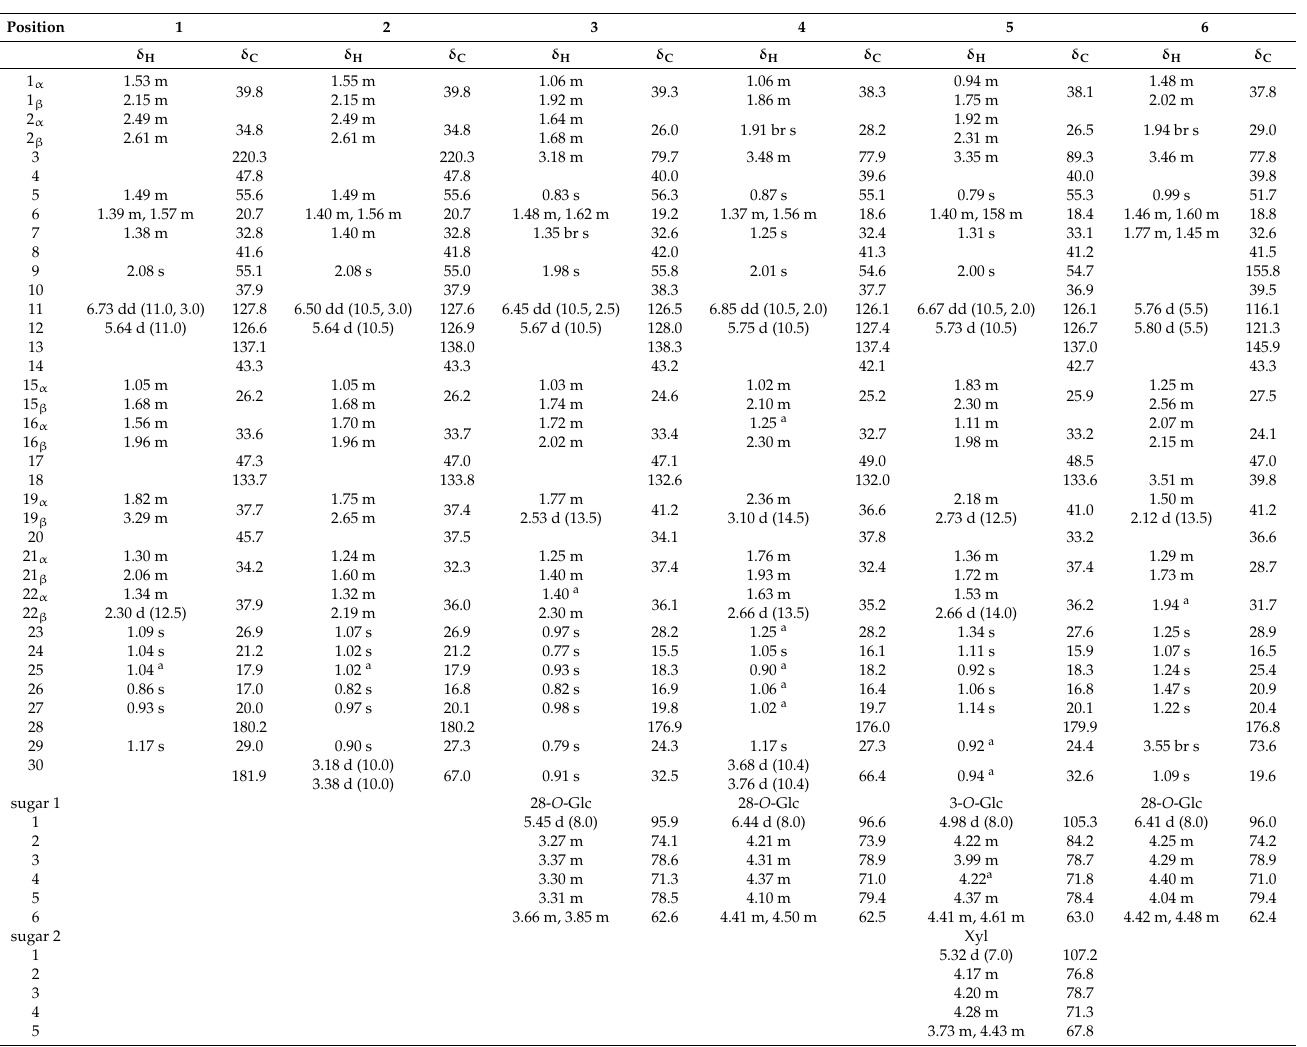
Table 1. 1 H- and 13 C-NMR data (500 and 125 MHz, respectively, 1 – 3 in CD 3 OD, 4 – 6 in C 5 D 5 N) of 1 – 6